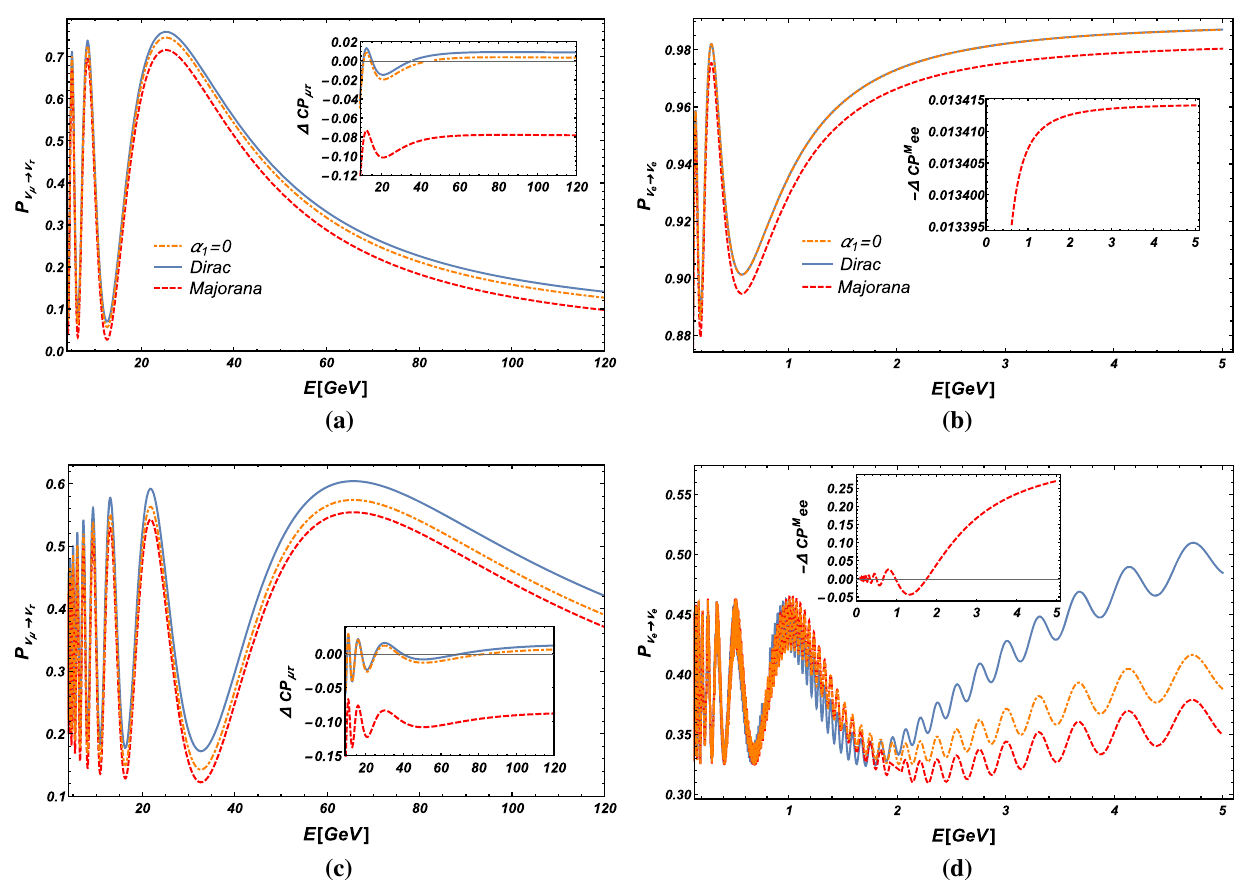
Fig. 1 a Plots of the transition probability P ν μ → ν τ as a function of the energy E for a diagonal dissipator α 1 = 0, for which Dirac and Majorana neutrinos have identical behavior (orange dot-dashed line) and for the off-diagonal dissipator for Dirac (blue solid line) and Majorana (red dashed line) neutrinos. Inset: corresponding plots of (cid:13) CP μτ . We consider the energy range (0–120) GeV corresponding to the accessible energies in the IceCube DeepCore experiment and set t = 6 . 58 × 10 22 GeV − 1 . b Plots of P ν as a function of the e → ν e energy for an off–diagonal dissipator in the case of Dirac (blue solid line) and Majorana (red dashed line) neutrinos. Notice that for this tran- sition, the behavior of Dirac neutrinos in the off–diagonal dissipator case is identical to that of the neutrinos in the case of a diagonal dis- sipator. Inset: plot of the CP violation in the channel ν e ↔ ν e